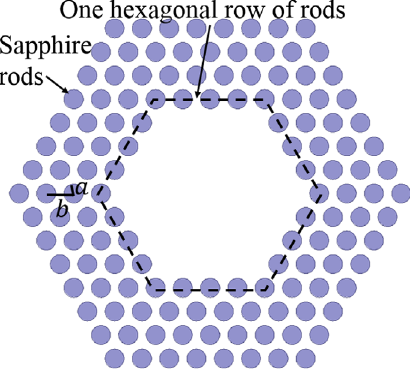
FIG. 1. A 2D, 4-row, dielectric PBG lattice array. The inner 37 rods have been omitted to form the cavity. The rod radius is a and the rod spacing is b .